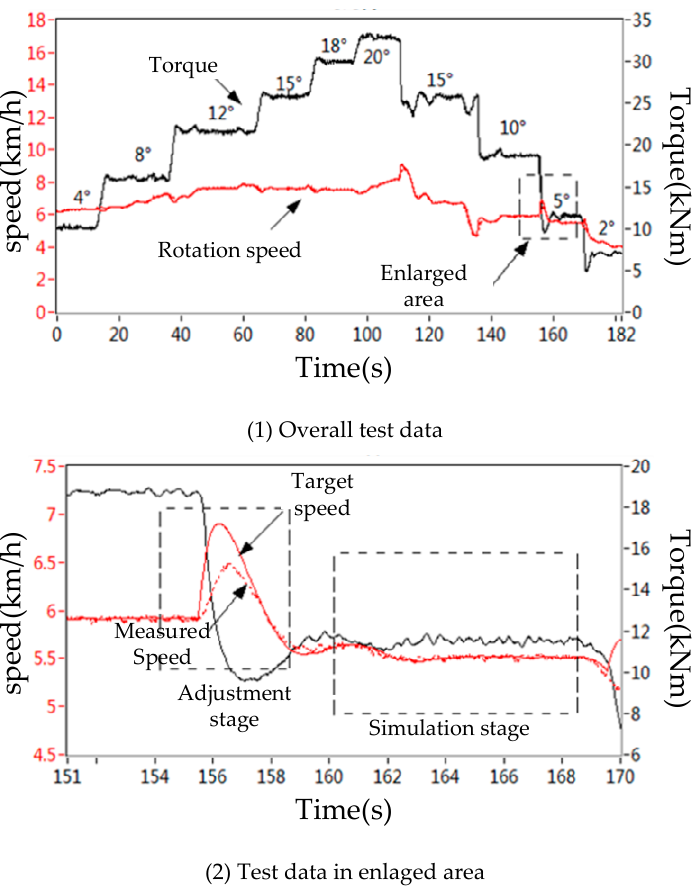
Figure 30. Longitudinal slope passing test.